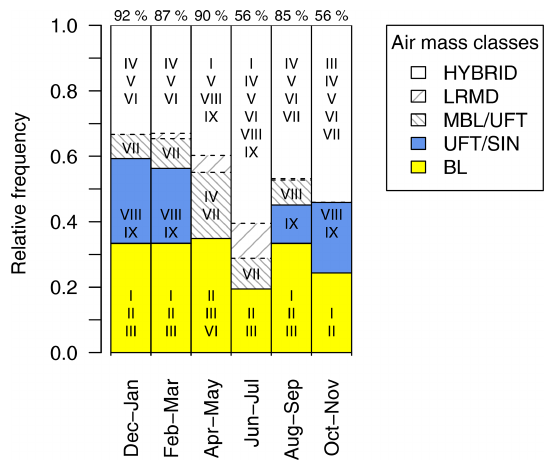
Figure 8. Relative frequency of the air mass classes as fraction of the classified cases in each 2-month period. The joint data avail- ability is given as fraction of time above the plot. LRMD (long- range transport of mineral dust) represents certain cases within the regimes that were not attributed to BL (recent contact with the boundary layer). LRMD and MBL/UFT (influence of the marine boundary layer or UFT) are part of HYBRID (influences of both the boundary layer and the free troposphere or ambiguous). UFT/SIN denotes undisturbed free troposphere or stratospheric